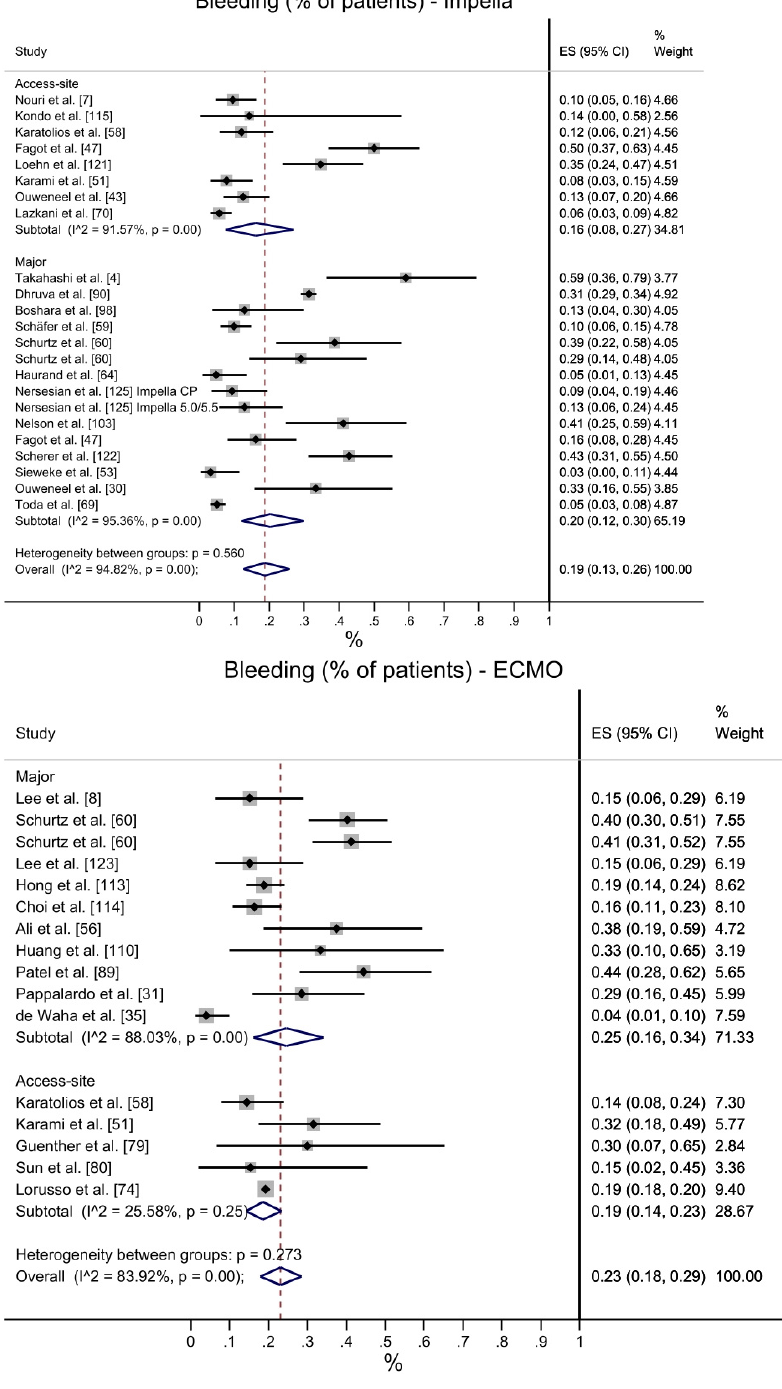
Figure 4. Bleeding: Impella vs. VA-ECMO. [4,7,8,30,31,35,43,47,51,53,56,58–60,64,69,70,74,79,80,89,90,98,103,110,113–115,121–123,125]